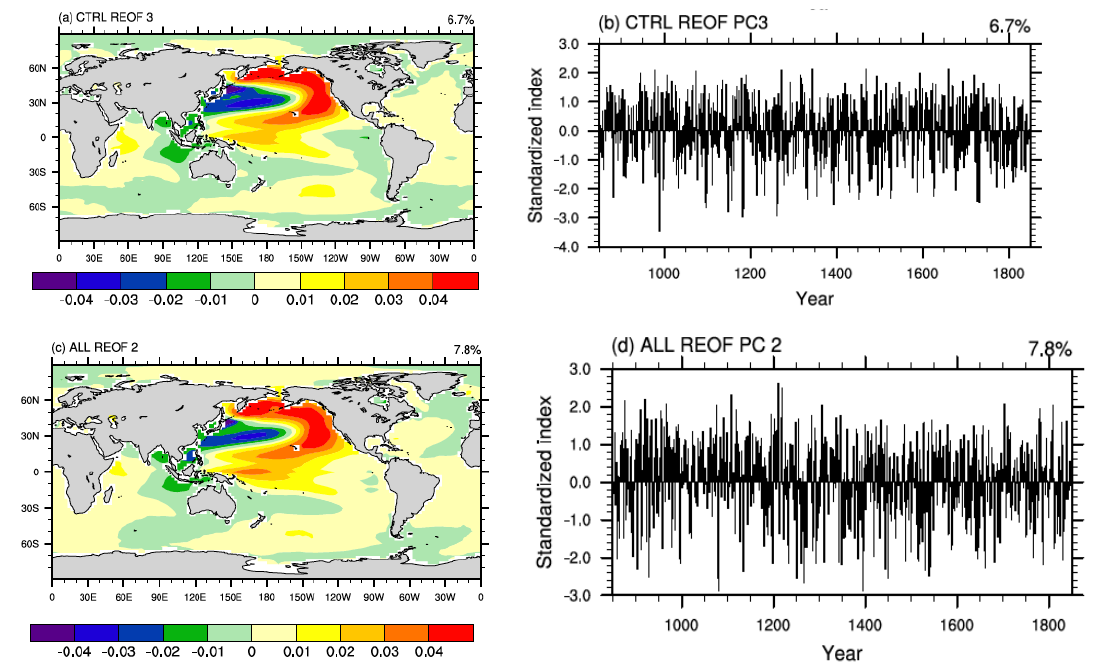
Figure 8. The third/second rotated empirical orthogonal function (REOF) spatial patterns and principle components of the global sea surface temperature (SST) from control (CTRL) ( a , b ) and all-forcing (ALL) ( c , d ) experiments.